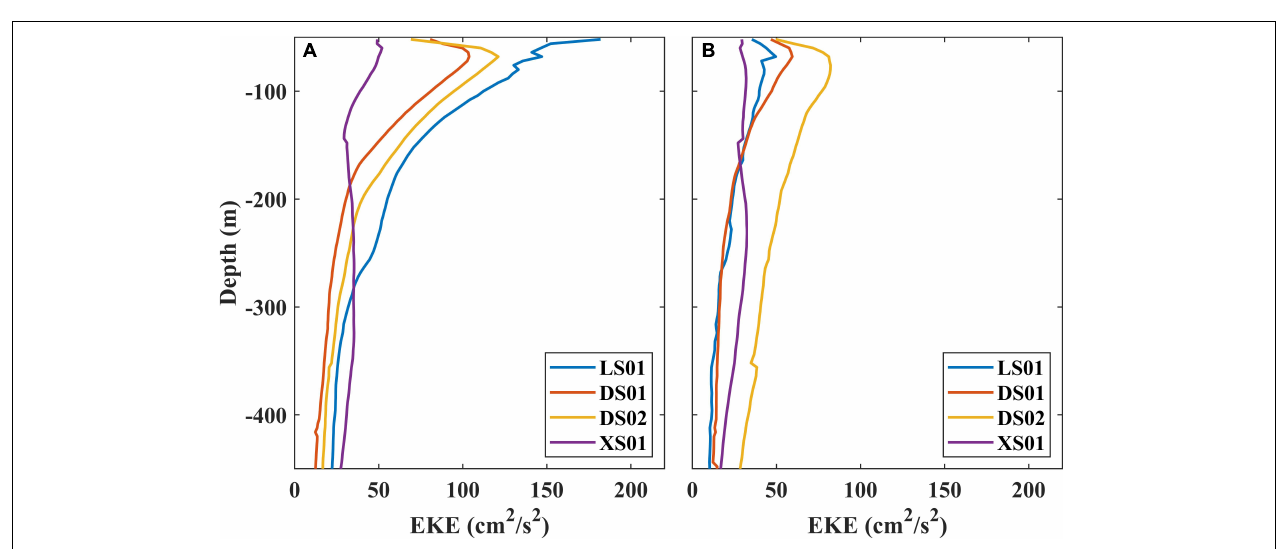
FIGURE 7 | Vertical structure of time-averaged eddy kinetic energy (cm 2 /s 2 ) at the period of (A) 10–65 days and (B) 65–110 days.